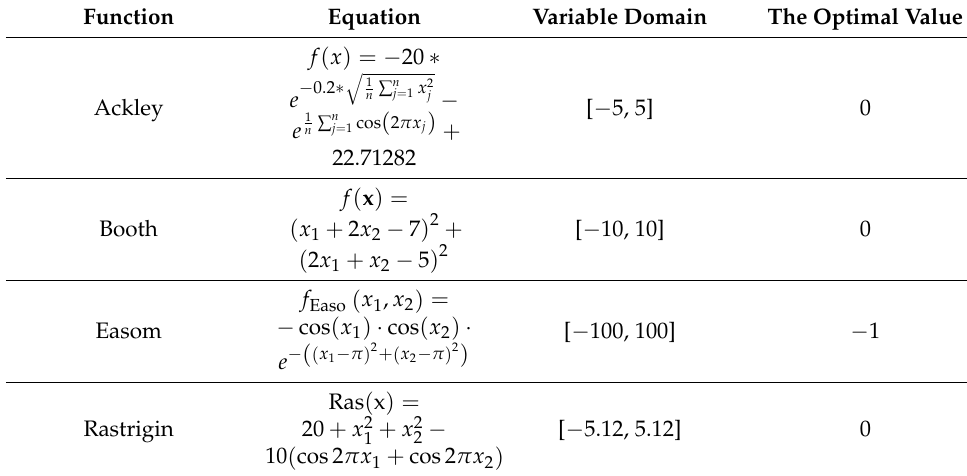
Table 6. Test the function variable scale.